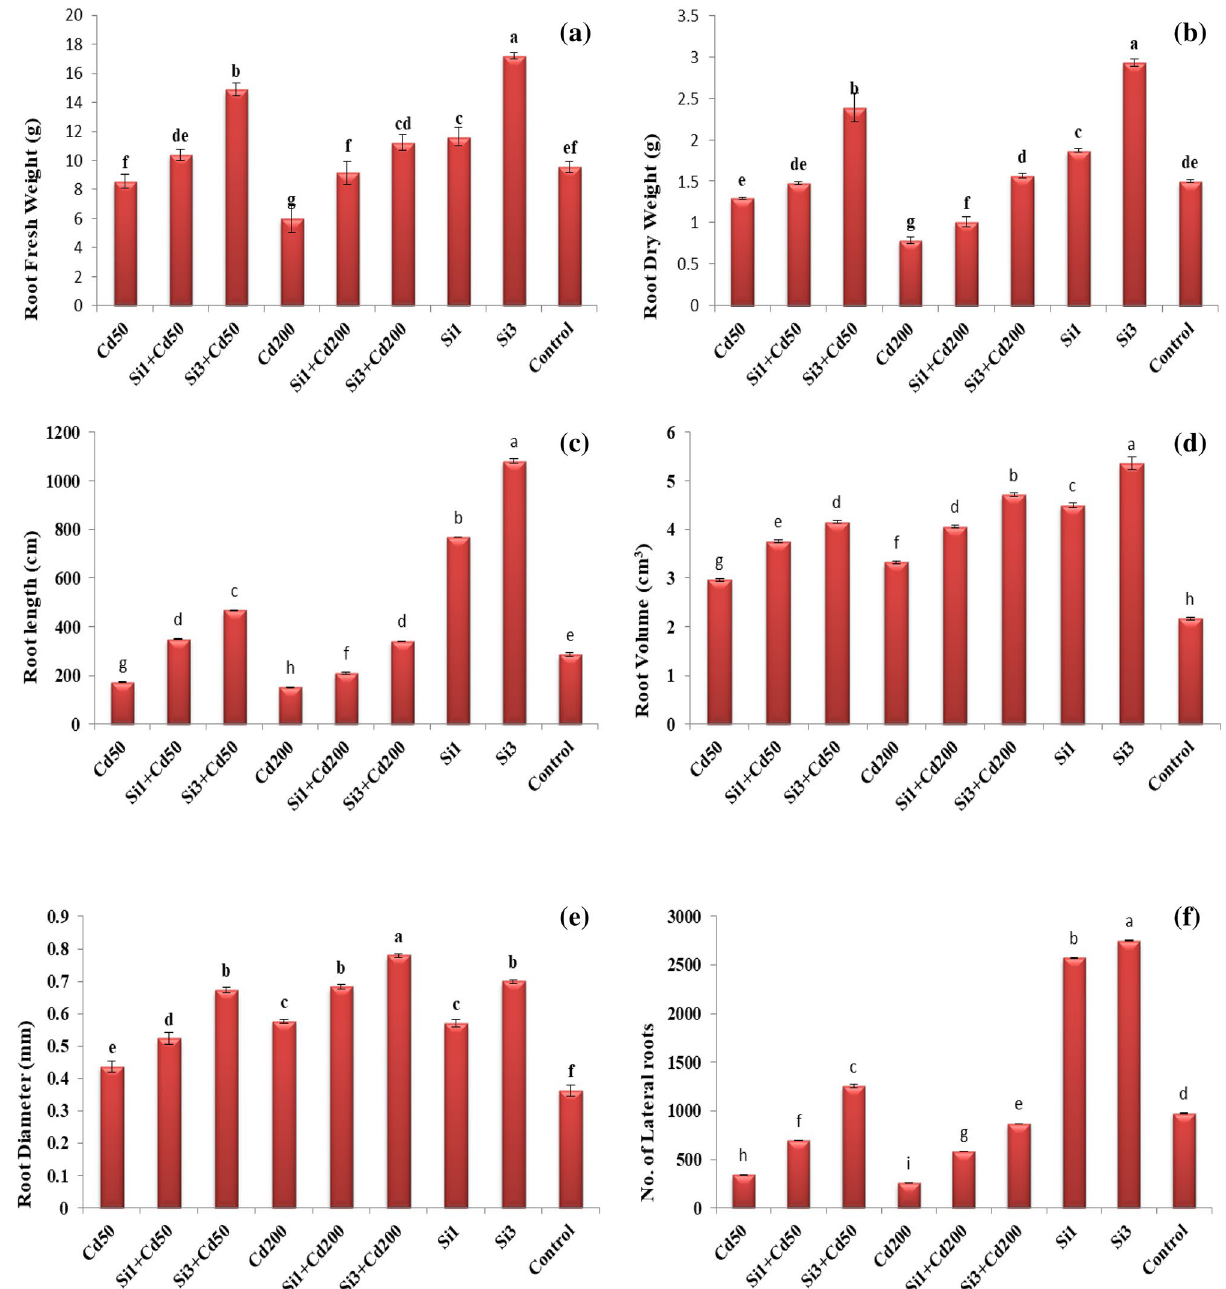
Figure 1. Effect of Si and Cd on root fresh weight (RFW) (g plant −1 ), root dry weight (RDW) (g plant −1 ), root length (R.L.) (cm), root diameter (R.D.) (mm), root volume (R.V.) (cm 3 ), root tips (R.T.) (no. of lateral roots) contents in the roots of wheat plants. The values are expressed as the mean ± S.D. (n = 3). The different superscript letters within a column indicate significant differences at P < Effect of silicon and cadmium on root volume and average diameter.